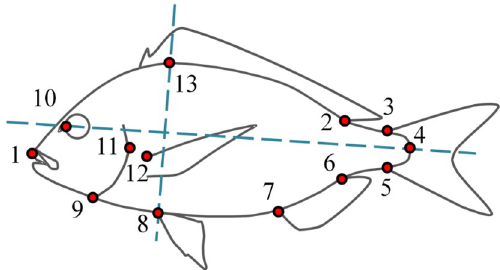
Figure 7. Landmarks collected in the present study. 1, Anterior tip of upper jaw; 2, posterior base of the dorsal fin; 3, dorsal tip of the base of caudal fin; 4, base of the central caudal lepidotrichium; 5, ventral tip of the base of caudal fin; 6, 7, posterior and anterior base of the anal fin, respectively; 8, base of the pelvic fins; 9, ventral tip of the gill cover; 10, anterior margin of the eye, dorsally to the nostril; 11, posterior tip of the gill cover; 12, dorsal base of the left pectoral fin; 13, projection of the landmark 8 on the dorsal profile of fish, perpendicularly to the axis which is defined by landmarks 4 and 10 (modified from Fragkoulis et al. 8